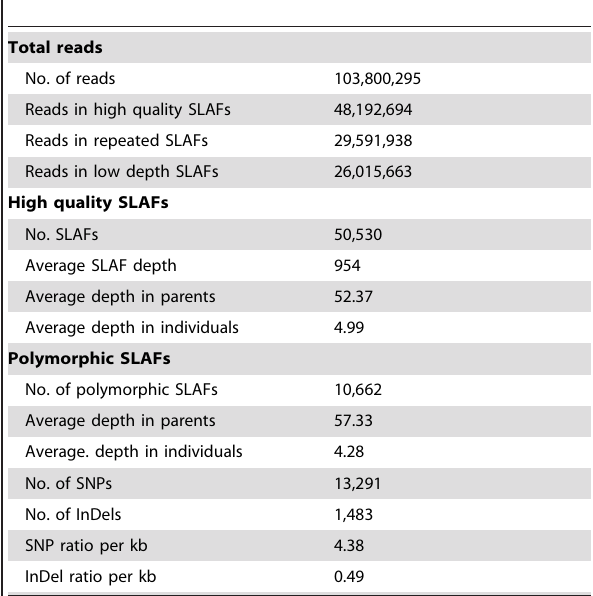
Table 1. Pilot SLAF-seq data summary in rice and soybeans. Genome information